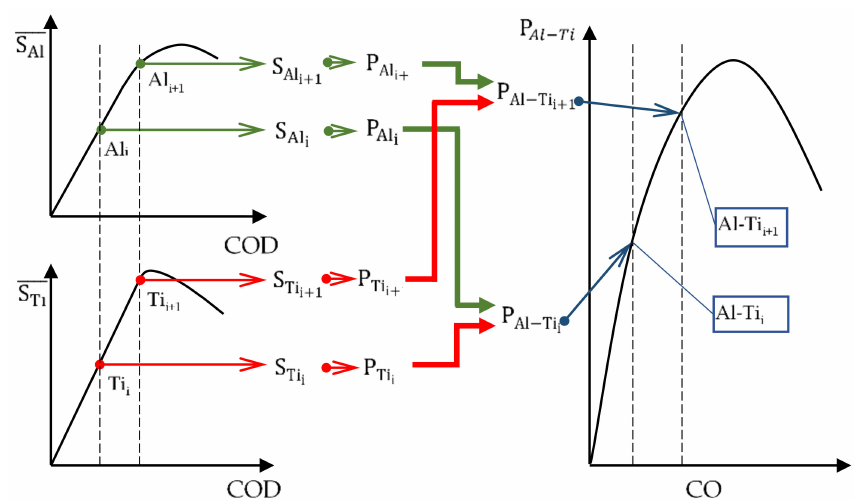
Figure 13. Scheme of determination of hypothetical load occurring in a layered material calculated on the basis of nominal stresses in specimens made of base materials.